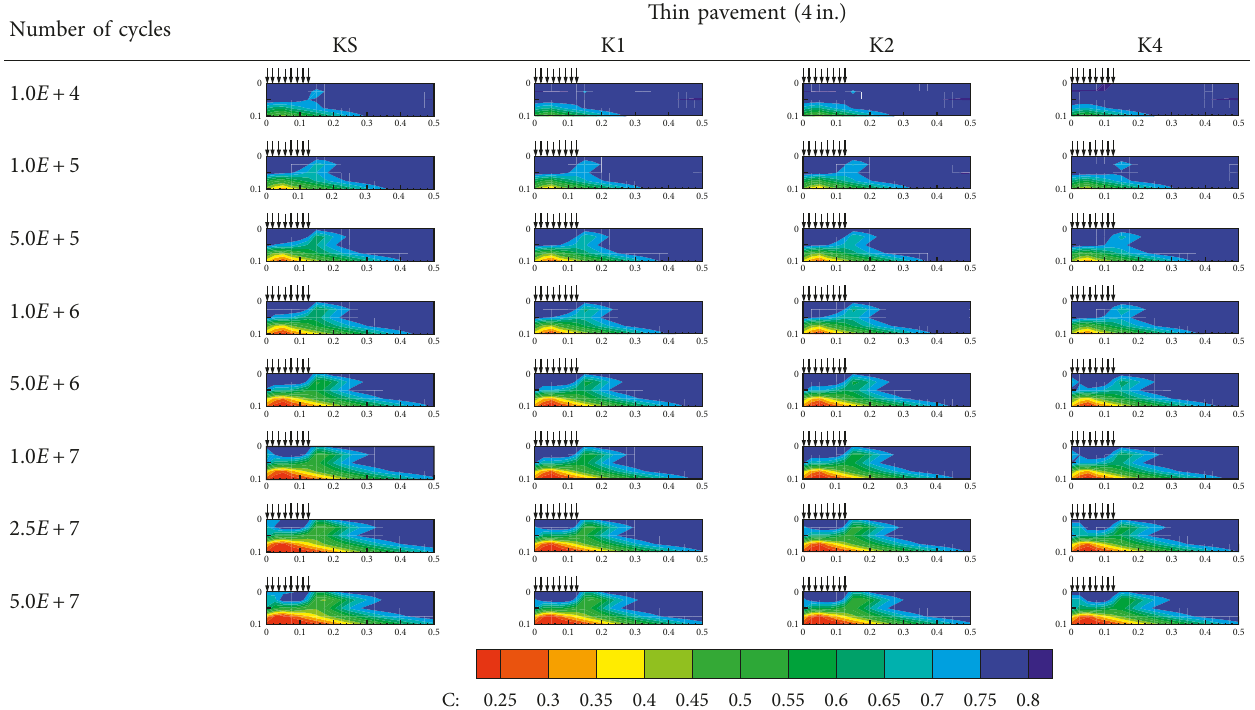
Table 6: Contour plots of C for thin pavements in color